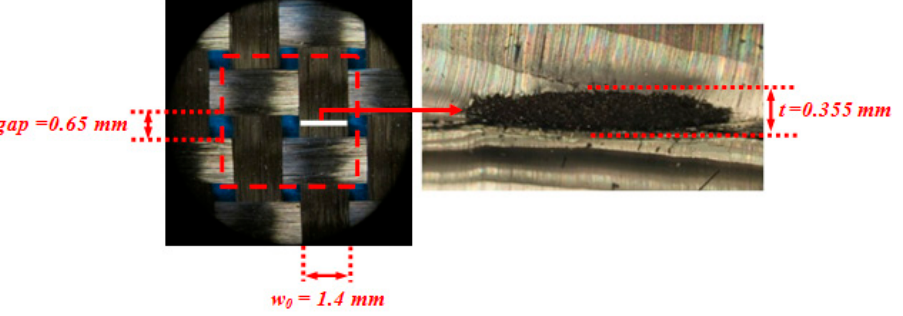
Figure 11. The geometric characteristics of the tested PWCP.